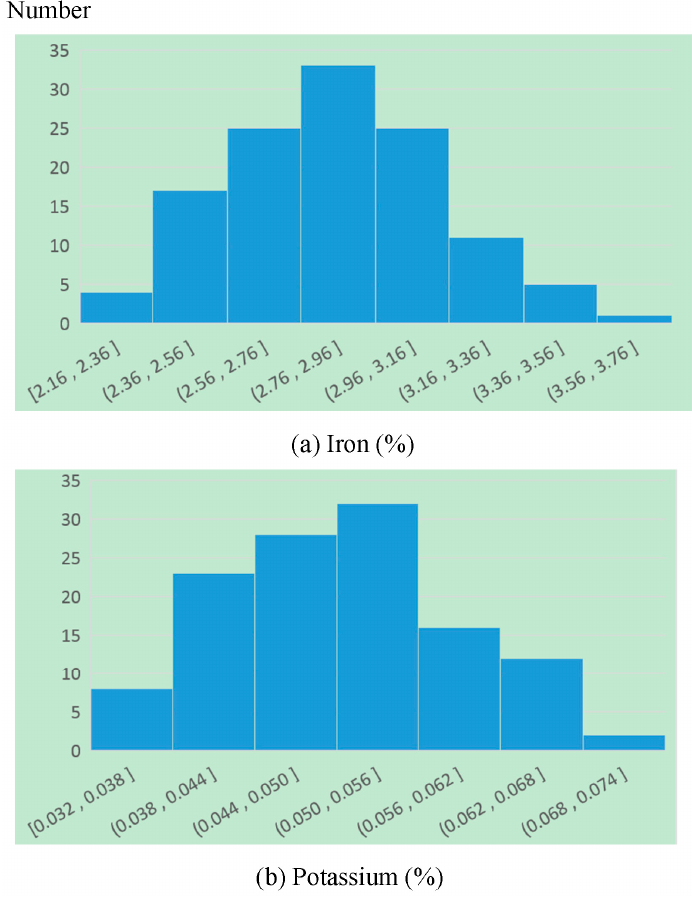
Figure 8. Iron ( a ) and potassium ( b ) histograms of fine sediments.